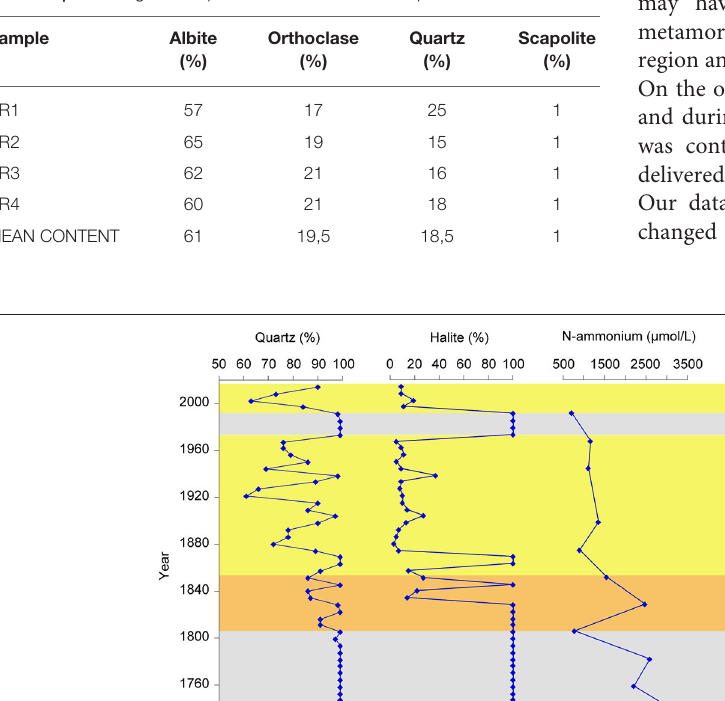
Frontiers in Earth Science |